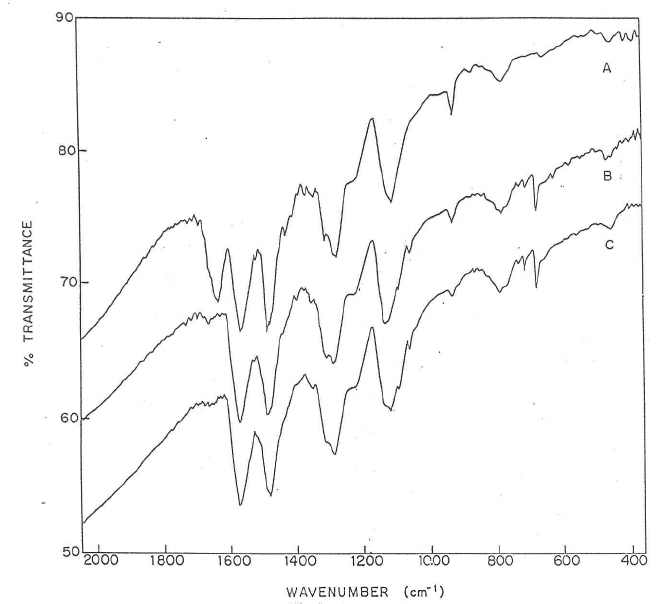
Figure 2. FT-IR spectrum of PANI-CuPc polymers (A) Pure PANI (B) PANI + 5% CuPc (C) PANI + 20% CuPc.